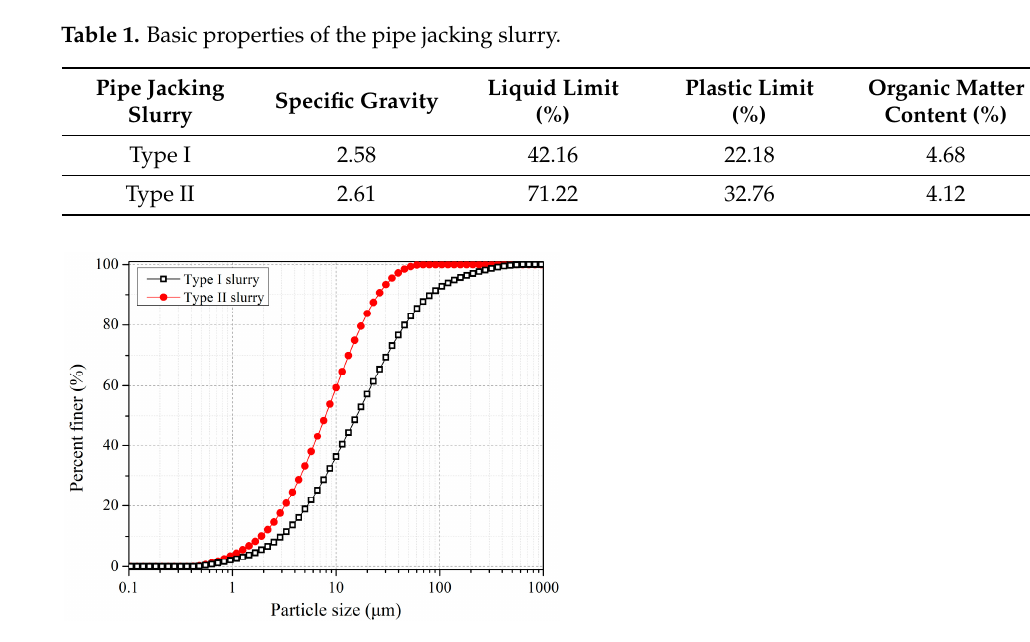
Figure 1. Particle size distribution of the pipe jacking waste slurry.